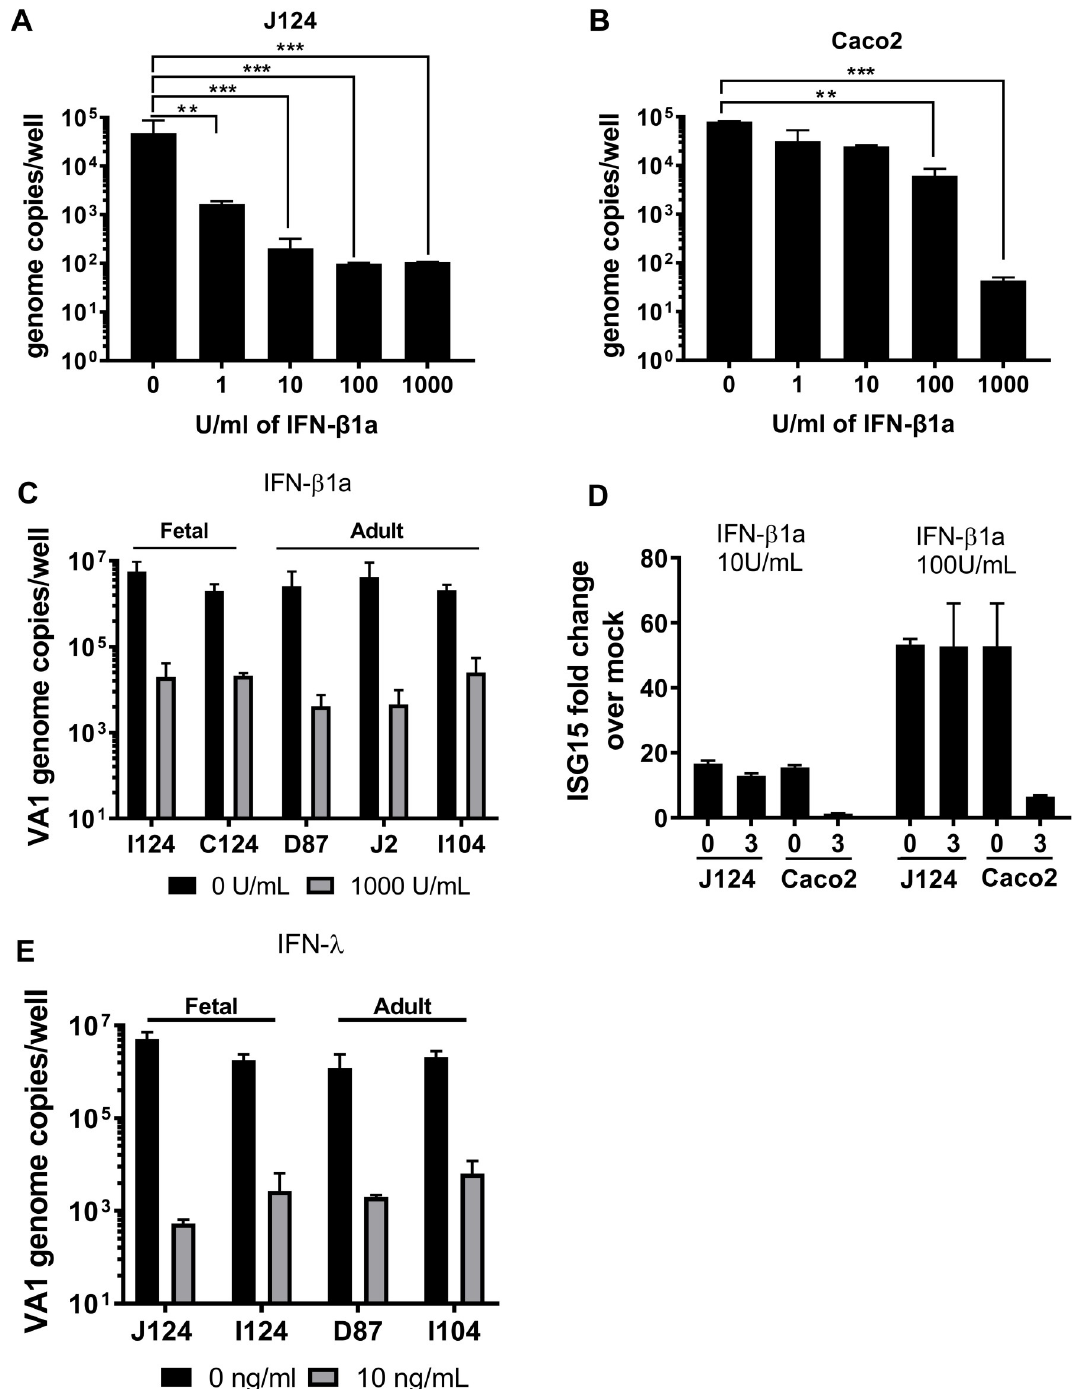
Fig 6. Astrovirus is sensitive to exogenous interferon. A) J124 HIE and B) Caco-2 cells were treated with increasing concentrations of IFN- β 1a 12 hrs before VA1 infection (MOI of 1). Viral genome copies were measured by RT-qPCR from extracted cellular RNA at 3 dpi. C) VA1 sensitivity to exogenous IFN- β in HIE derived from different human intestinal segments. Fetal (I124 and C124) and adult (D87, J2 and I104) HIE were treated with IFN- β 1a (1000 U/ml) 12 hrs before VA1 infection. VA1 genome copies were measured by RT-qPCR at 3 dpi. D) J124 and Caco-2 cells were treated with 0, 10, and 100 U/ml IFN- β 12 hrs before VA1 infection. ISG15 transcript levels in VA1-infected HIE or Caco-2 cells were measured at 0 dpi and at 3 dpi. The ISG15 fold increase was calculated comparing to 0 U/ml IFN- β treated cells after normalizing to GAPDH. E) J124, I124, D87 and I104 HIE were pre-treated with IFN-